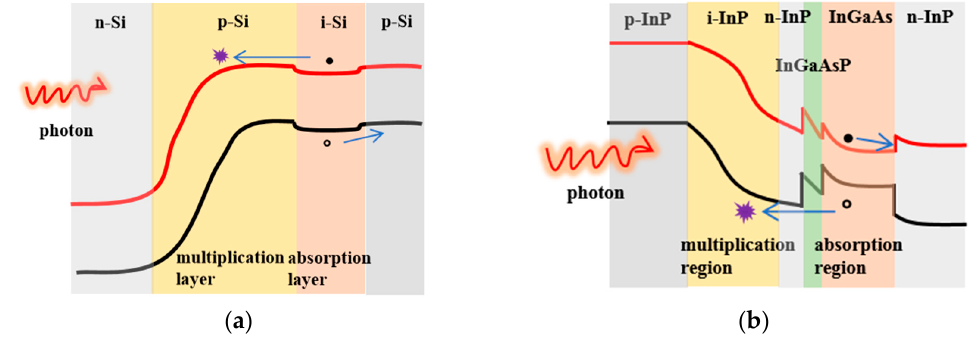
Figure 5. The schematic band diagrams of a ( a ) Si-based APD and an ( b ) InP-based APD, with the transportation process of photo-generated carriers is also shown.